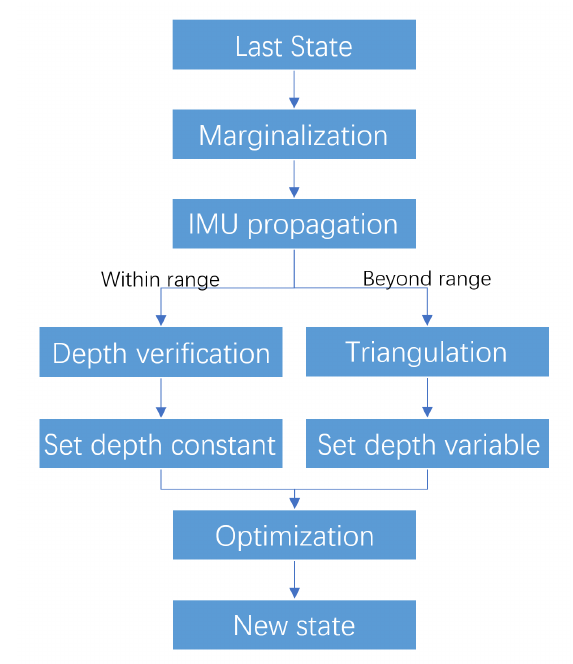
Figure 4. Depth integrated VIO